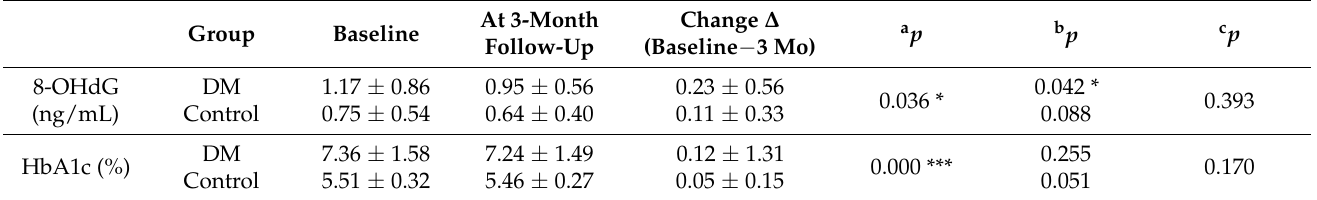
Table 4. Comparison of 8-OHdG and HbA1c at baseline and at three months upon periodontal therapy